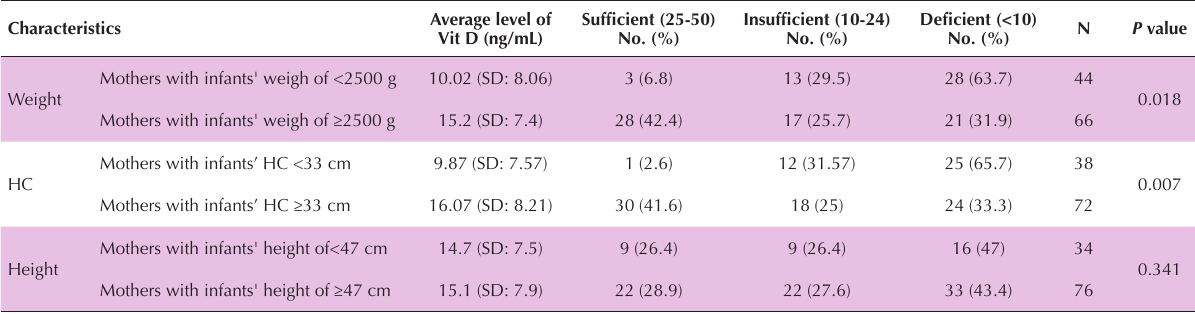
Table 2. Infants’ characteristics and mother’s vitamin D level Characteristics